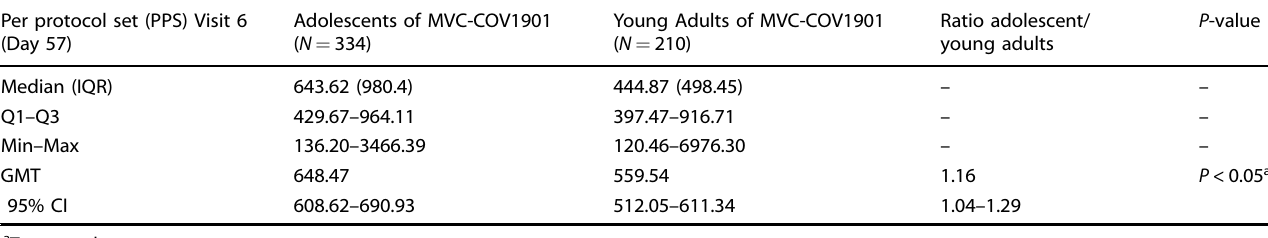
Table 3. Summary of non-inferiority of live SARS-CoV-2 neutralizing antibody titers between adolescent and young adults who received MVC- COV1901 (in IU/mL).